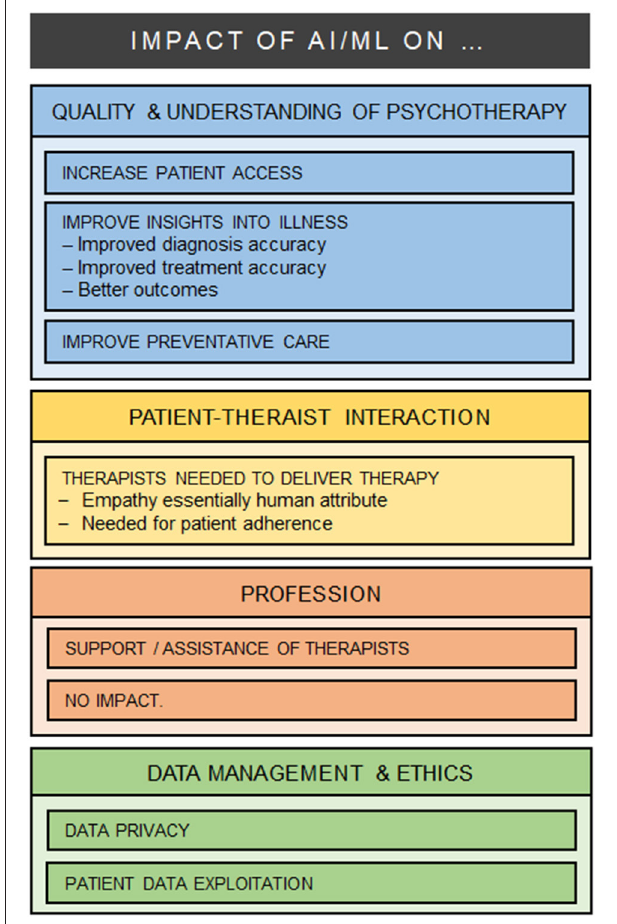
FIGURE 1 | Themes and